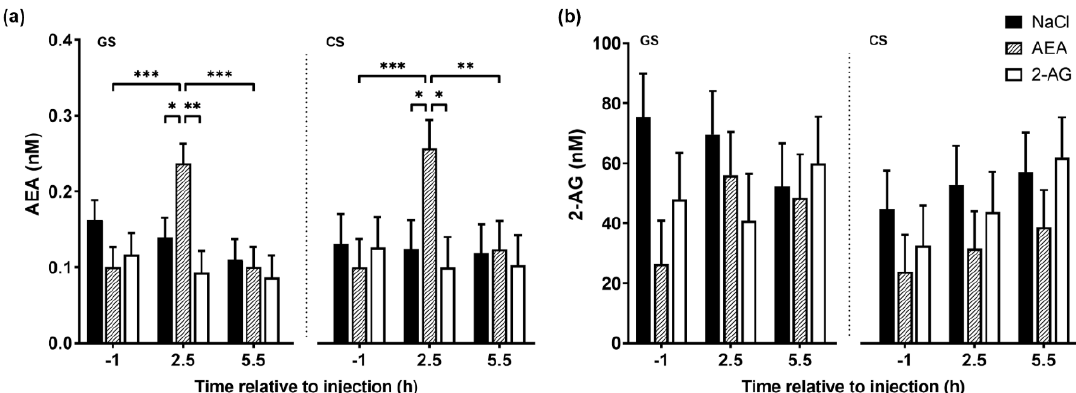
Figure 2. Plasma endocannabinoid concentrations on day 8, 1 h before, 2.5 h and 5.5 h after intraperitoneal administration with NaCl ( n = 7), AEA ( n = 7) or 2-AG ( n = 6). Cows were fed ad libitum a grass silage (GS) and corn silage (CS)-based diet. Data for ( a ) AEA (nM) and ( b ) 2-AG (nM) are shown as LSM ± SE. Treatment and time differences are indicated by * p < 0.05, ** p < 0.01 and *** p < 0.001 (Tukey–Kramer). ANOVA results are presented in Table S3. Table 1. Relative mRNA abundances (LSM ± SE) of orexigenic neuropeptides and genes related to the ECS of the arcuate nucleus (ARC) and paraventricular nucleus (PVN). Samples were obtained from cows treated with NaCl ( n = 7), AEA ( n = 7) or 2-AG ( n = 6) for 9 days. Gene NaCl AEA